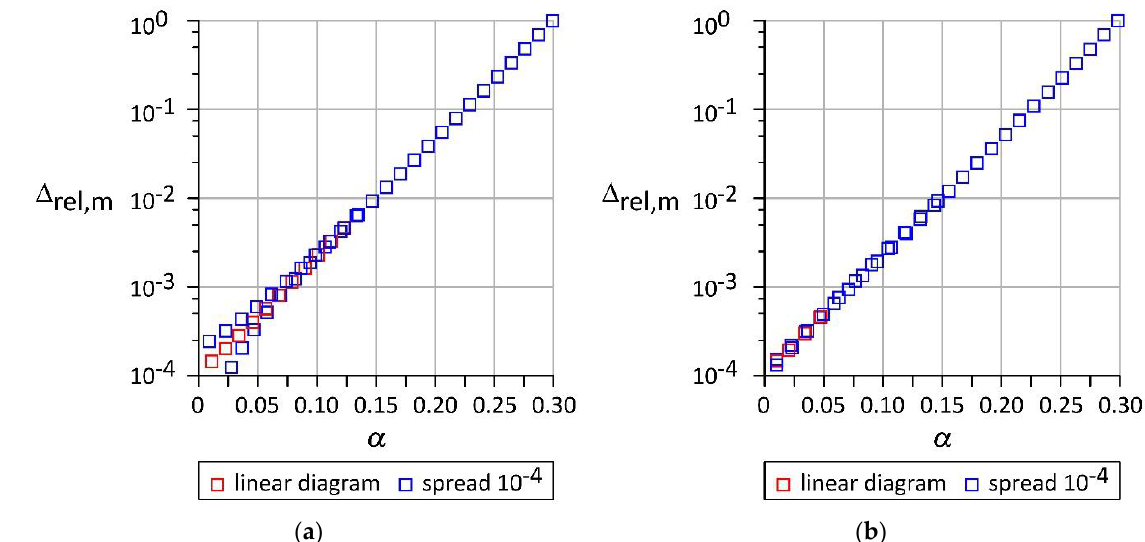
Figure 9. The relative error of a certain probabilistic moment of a theoretical approximation depending on the spread Δ appr and the input coefficient of variation: ( a ) Δ appr = 10 − 4 , ( b ) Δ appr = 10 −5 .